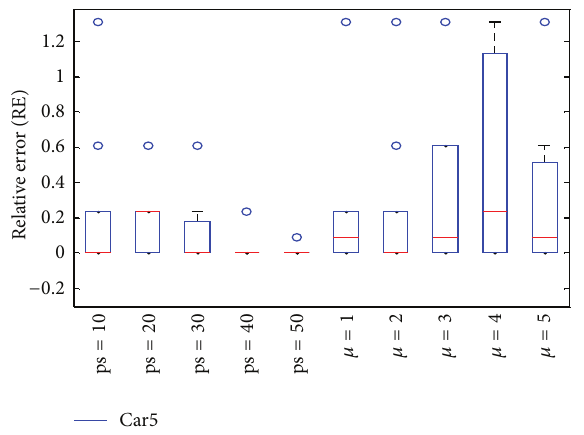
Figure 3: Box-and-whisker diagram of Car5.